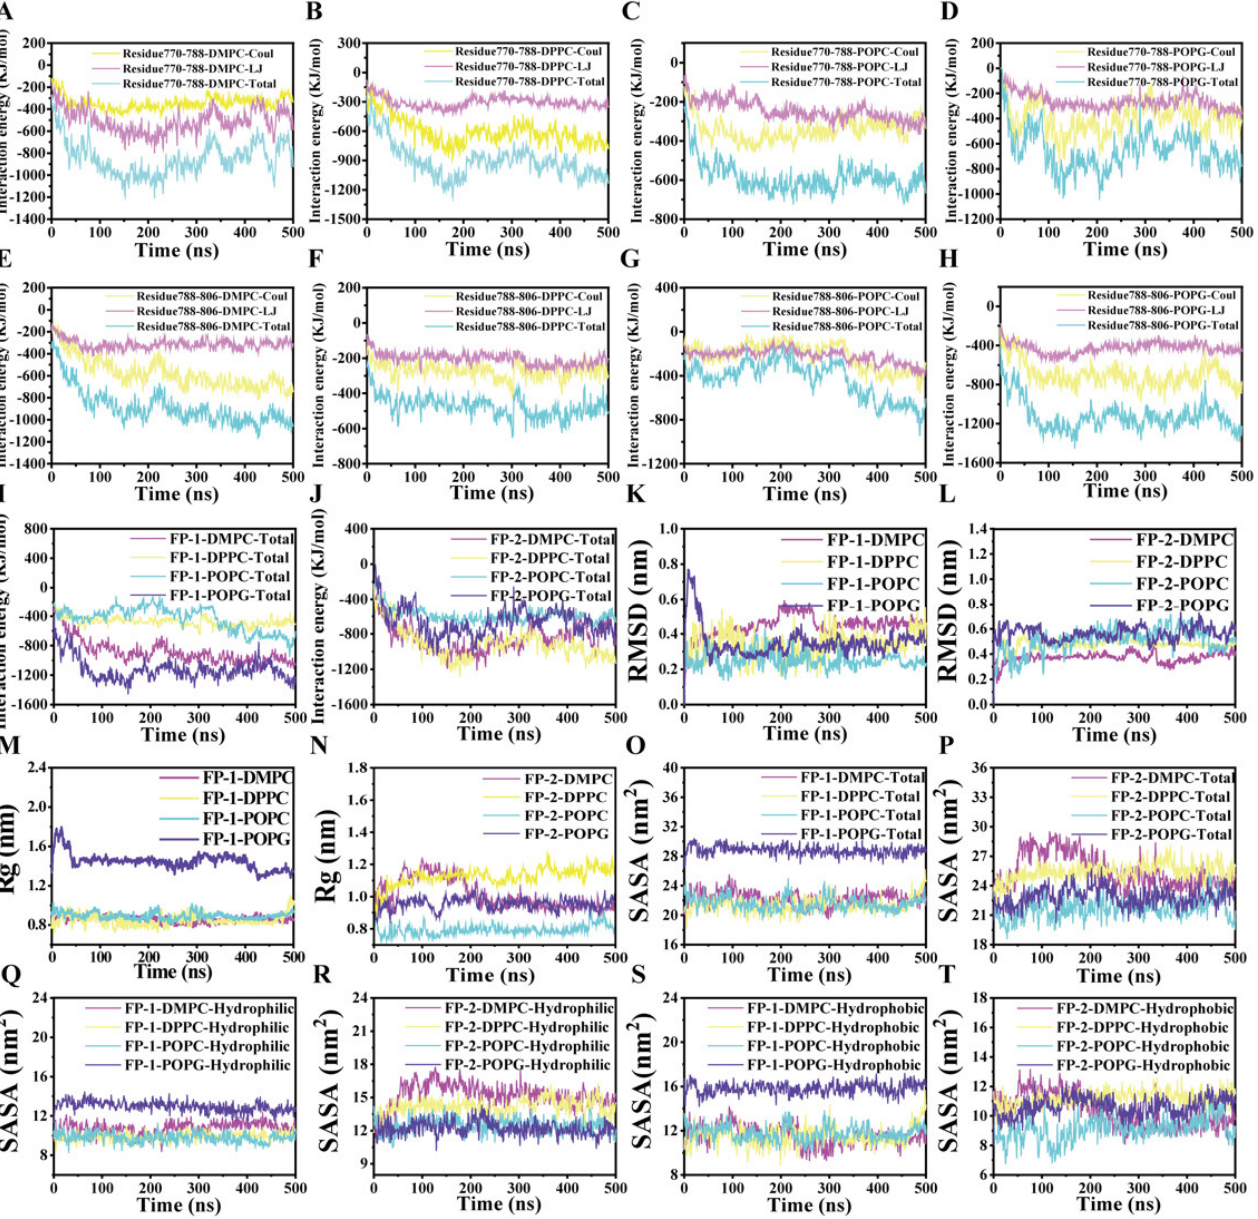
Figure 4. The data analysis during the whole simulation. ( A – H ) The time evolution of the interaction energy between these two functional peptides and the four lipid membranes, in terms of the electrostatic components (Coulomb) and van der Waals (LJ). ( I , J ) The time evolution of the total interaction energy for these two functional peptides in four lipid membranes during the whole simulation. ( K , L ) The time evolution of the RMSD for these two functional peptides in four lipid membranes during the whole simulation. ( M , N ) The time evolution of the Rg for the functional peptides in four lipid membranes during the whole simulation. ( O , P ) The time evolution of the SASA for these two functional peptides in four lipid membranes during the whole simulation. ( Q – T ) The time evolution of the SASA for these two functional peptides in four lipid membranes. The decomposition of the total SASA is the hydrophobic areas and the hydrophilic areas.